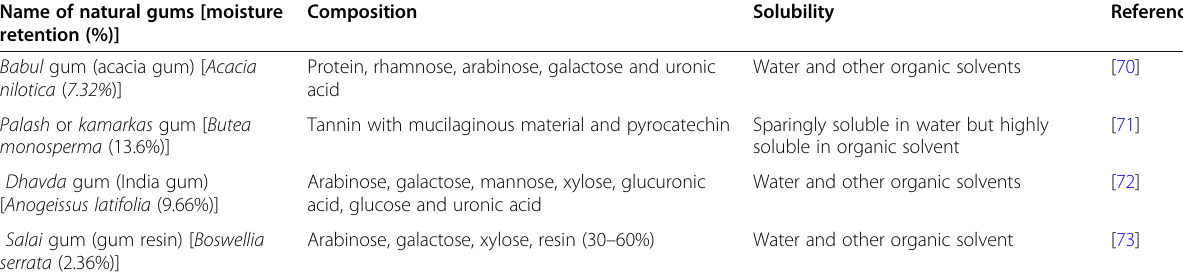
Table 3 Composition of natural gums and their solubility in water and organic solvents Name of natural gums [moisture retention